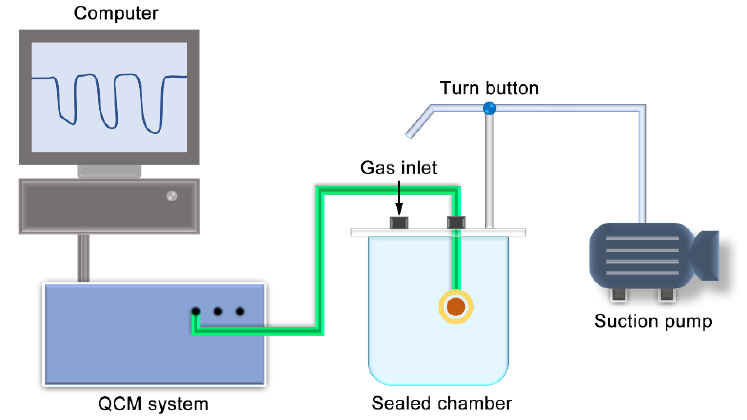
Scheme 1. Diagrammatical illustration of the QCM sensing test